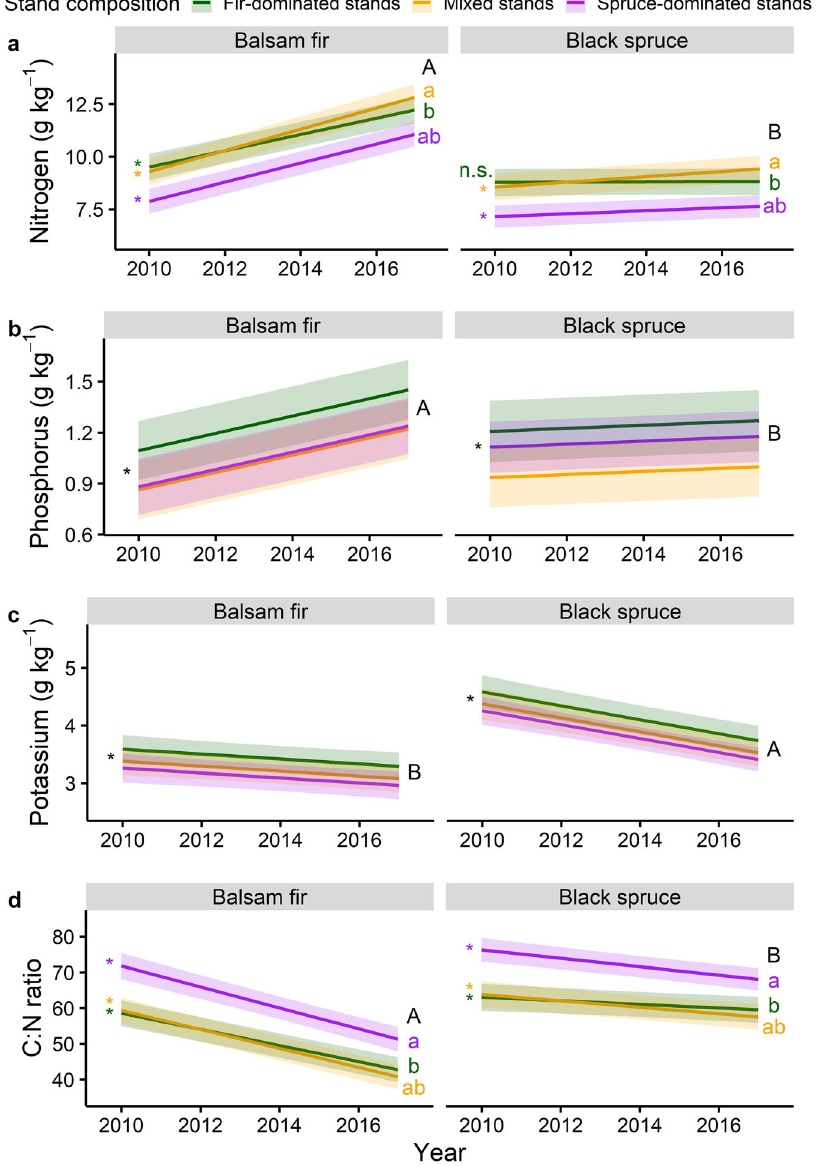
Fig. 4 Nutrients concentration in foliar tissue of living SBW host trees with annual progression of the outbreak. Fitted relationships for nitrogen ( a ), phosphorus ( b ), and potassium ( c ) concentrations (g kg − 1 ) and C:N ratio ( d ) with years (calendar years) and stand composition in needles taken off branches of living balsam fi r and black spruce trees. Shaded areas indicate 95% con fi dence intervals. Slopes signi fi cantly different from zero are identi fi ed with an asterisk. Lowercase letters in color compare slopes among stand composition (when the interaction between year and stand type was included in the model) and uppercase letters in black compare slopes between species. Total sample size was 1693